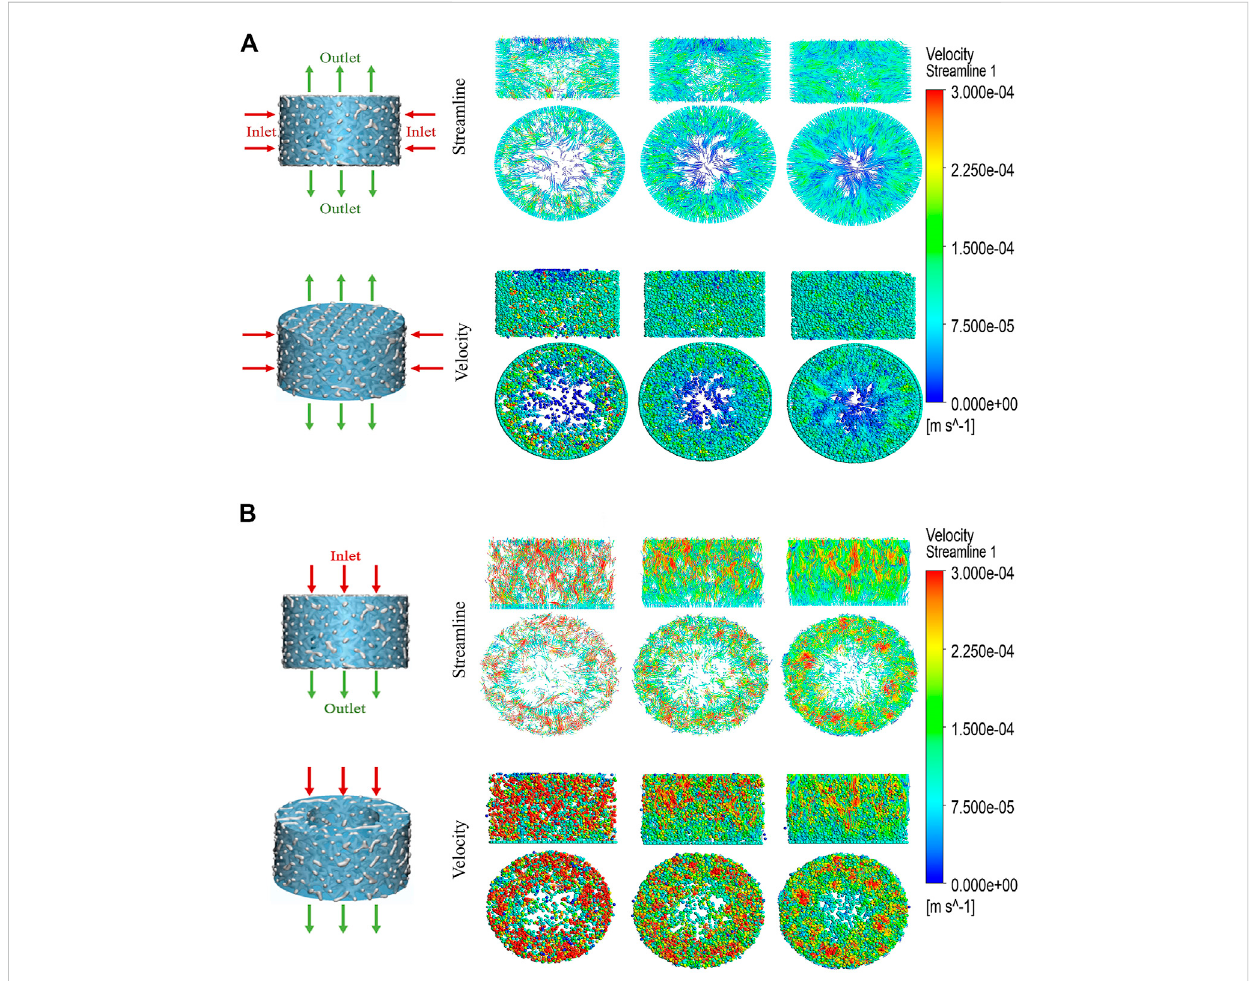
FIGURE 3 CFD simulation analysis of biomechanically stable pergola-like additively manufactured scaffold with different porosity (A) Horizonal direction of CFD simulation, the inlet was from outside to inside, the outlet was from center to top and bottom (B) Vertical direction of CFD simulation, the direction from inlet to outlet was from top to bottom. Streamline and velocity fi eld distribution and variation from the inlet to the